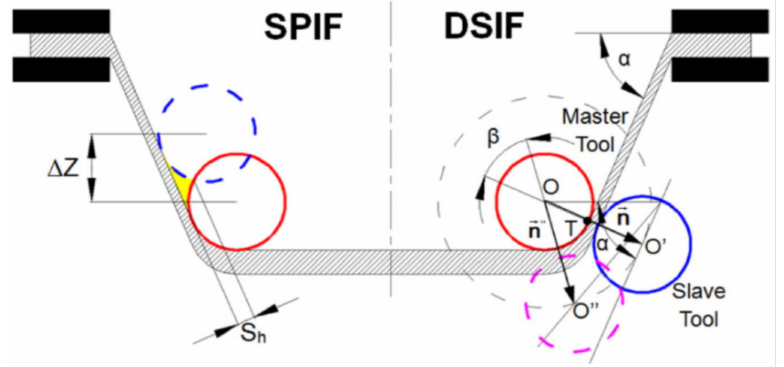
Figure 12. Comparison between tool paths in SPIF and DSIF (reproduced with permission from [103]; copyright © 2015 Elsevier Ltd. All rights reserved).